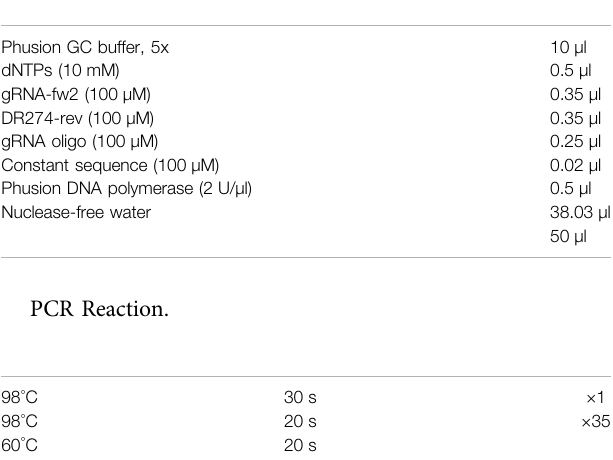
Table S1 for sequences]. The DNA template oligo for Tyr guide RNA was adapted from the work of Fei et al. (2018). The DNA template oligo was ampli fi ed using the